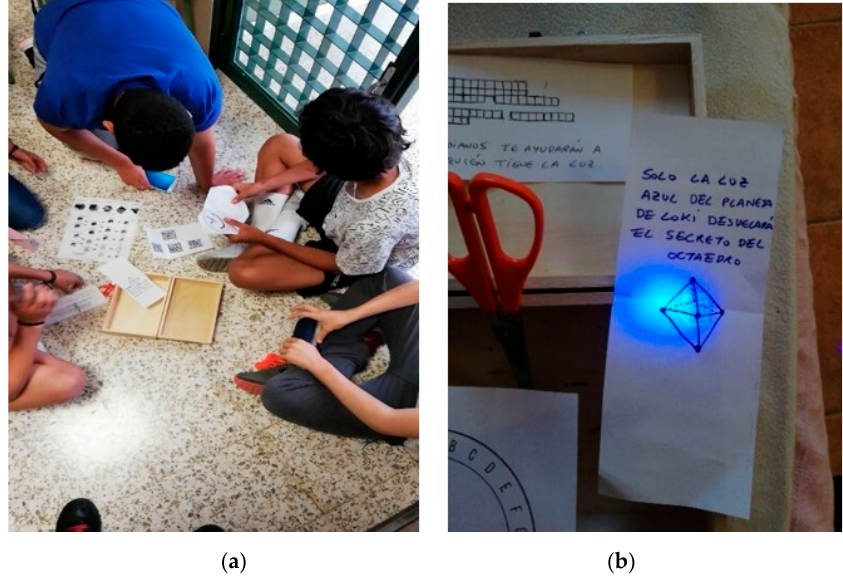
Figure 13. ( a ) capture of videogame quiz in Genially; ( b ) elements for Breakout EDU.